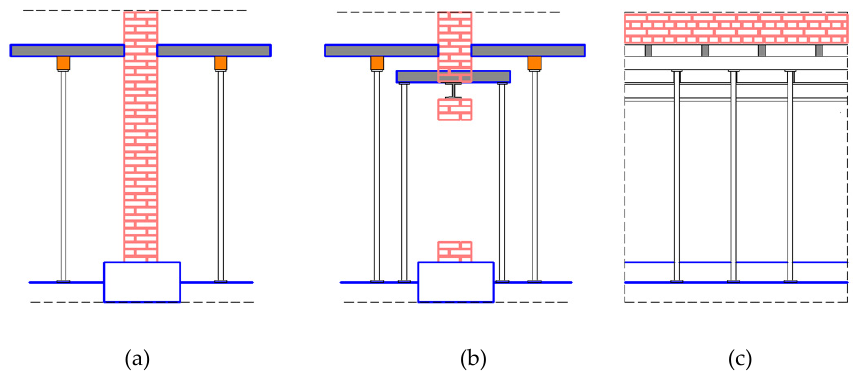
Figure 8. Demolition of a damaged URM wall and construction of a new wall: ( a ) scaffolding and formwork prepared for wall demolition; ( b ) setup for supporting upper portion of the wall, and ( c ) a side view of the arrangement for supporting upper portion of the wall.